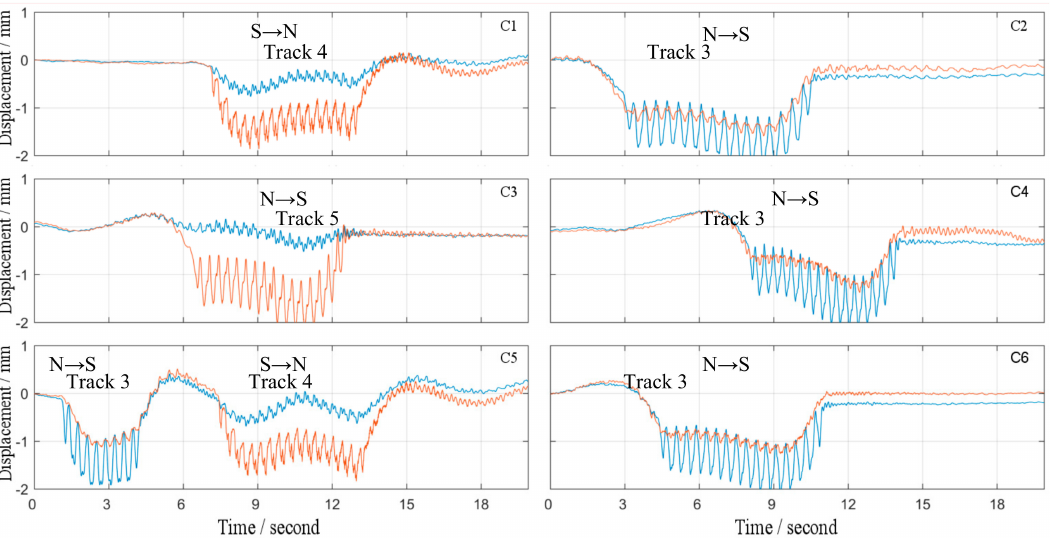
Figure 18. Comparison of vertical displacement histories of the bridge deck at (light blue) upstream and (orange) downstream